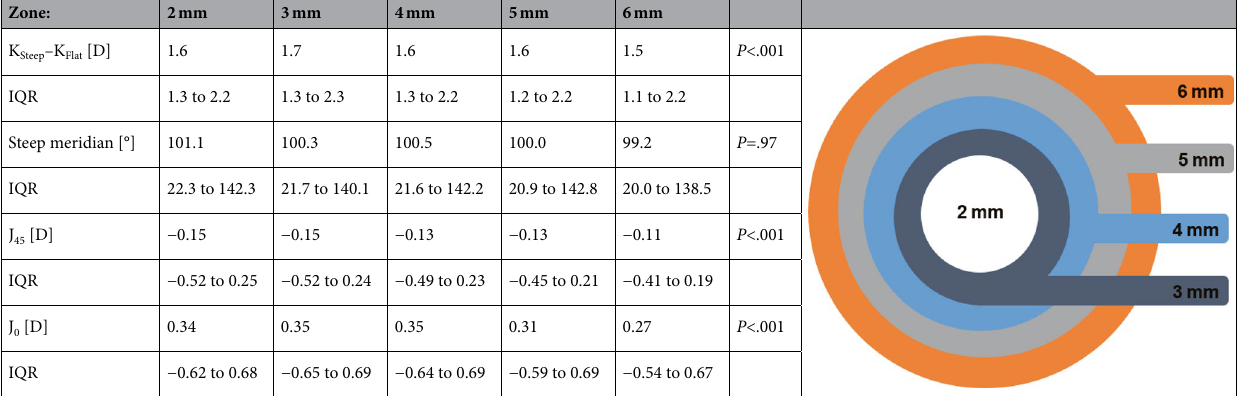
Table 1. Description of corneal astigmatism measured in five concentric zones from 2 to 6 mm. J 45 and J 0 are power-vector components (see Methods for more details). The p value was determined using the Friedman test for repeated measures comparison. K = keratometry; IQR = interquartile